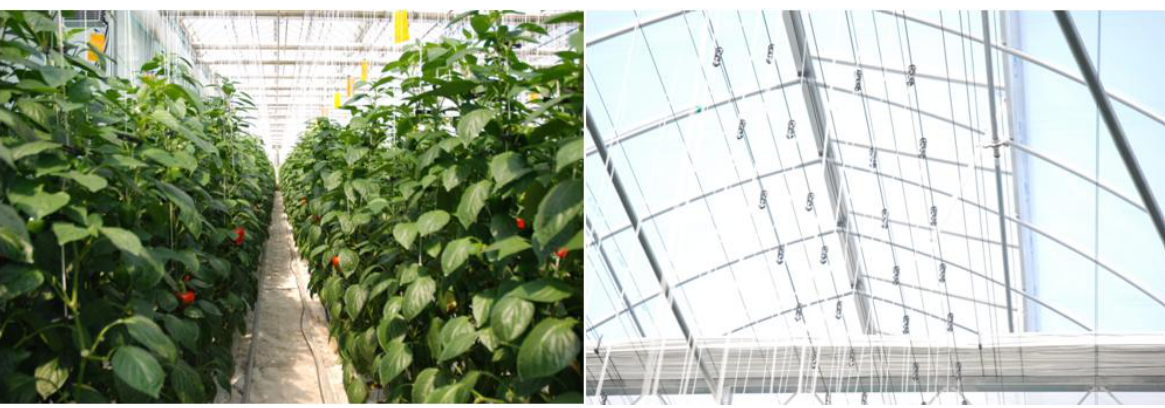
Figure 11. Installation site of the Ubiquitous Paprika Growth Management System: